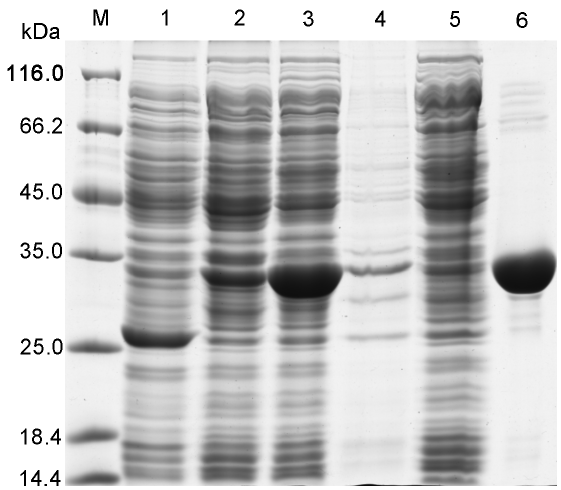
Figure 1. SDS-PAGE analysis of the expression and purification of DadB. M, marker; lane 1, supernatant of E. coli BL21(DE3) without any vectors; lane 2, supernatant before induction; lane 3: supernatant after induction; lane 4, resuspended precipitate; lane 5, flow-through after binding; and lane 6, purified DadB.